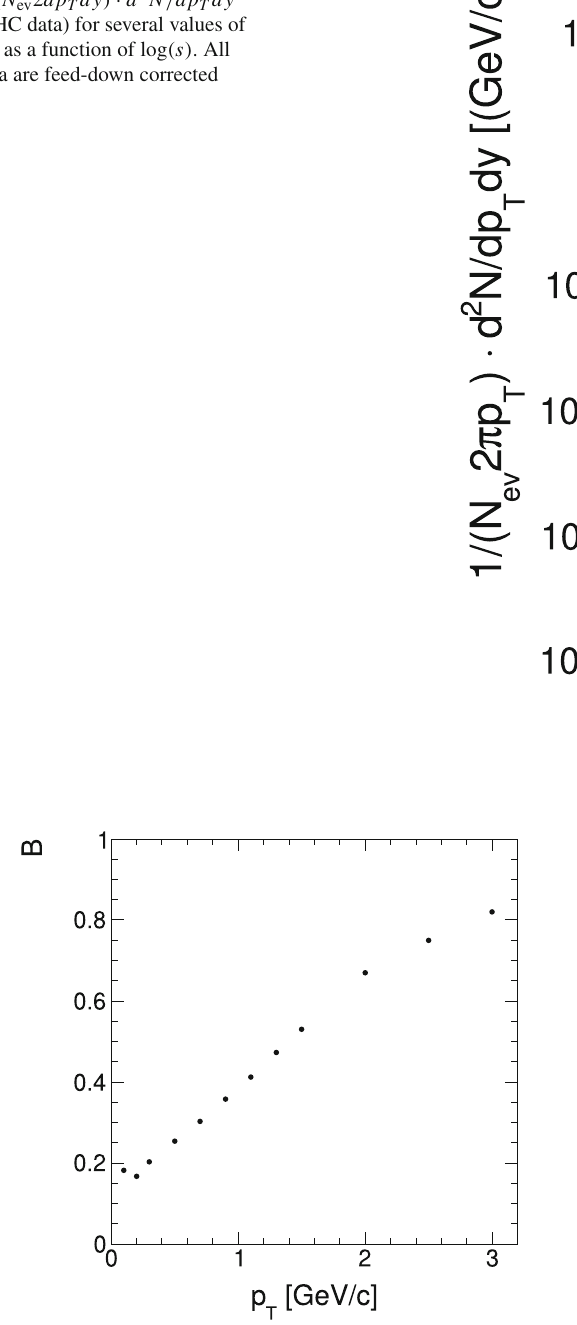
Fig. 86 Invariant π − densities f /σ inel (low energy data) and 1 /( N ev 2 dp T dy ) · d 2 N / dp T dy (LHC data) for several values of p T as a function of log ( s ) . All